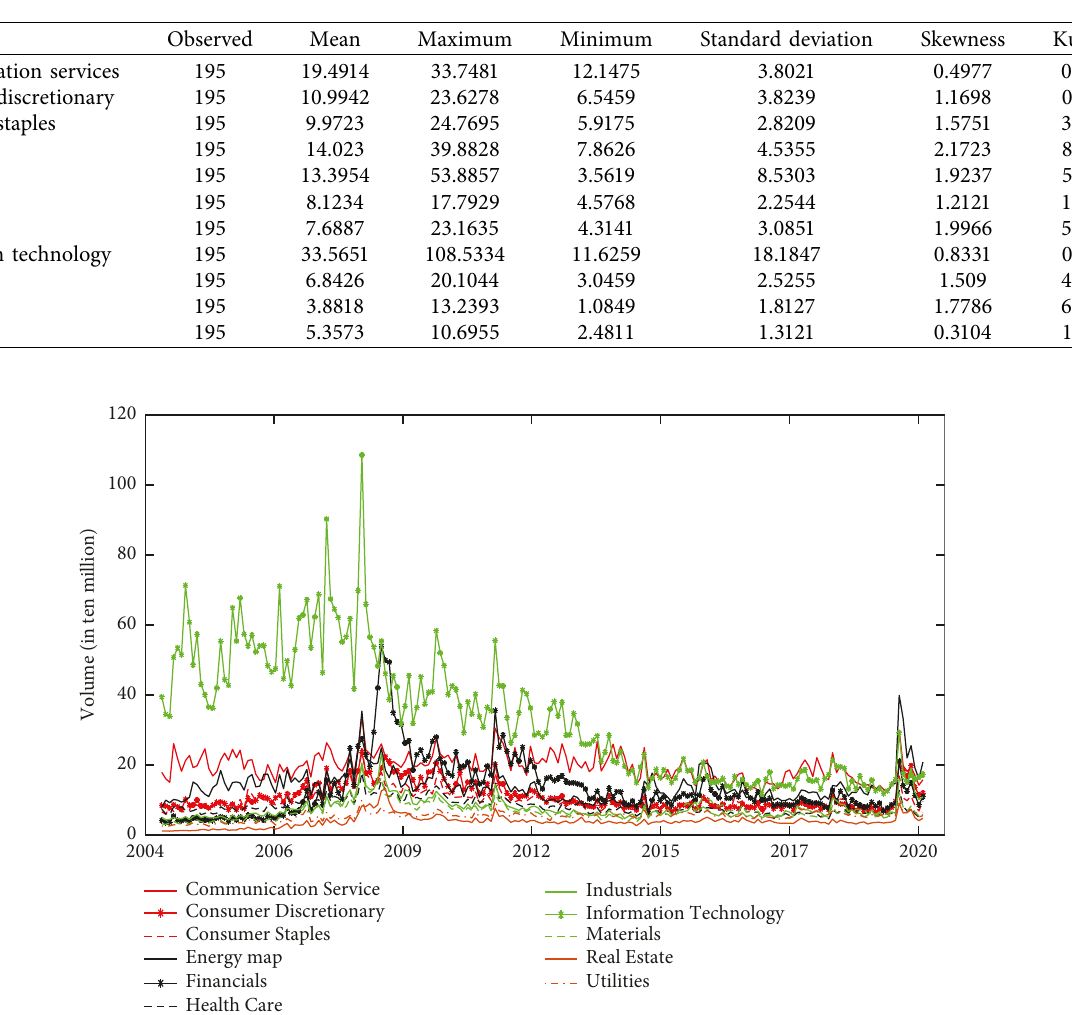
Figure 2: MATV ( r